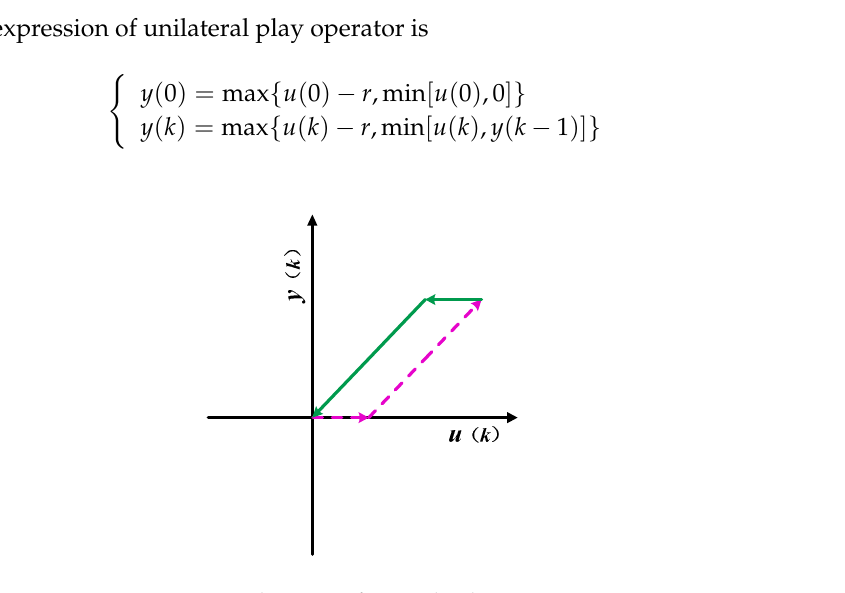
Figure 13. Schematic of one side play operator.